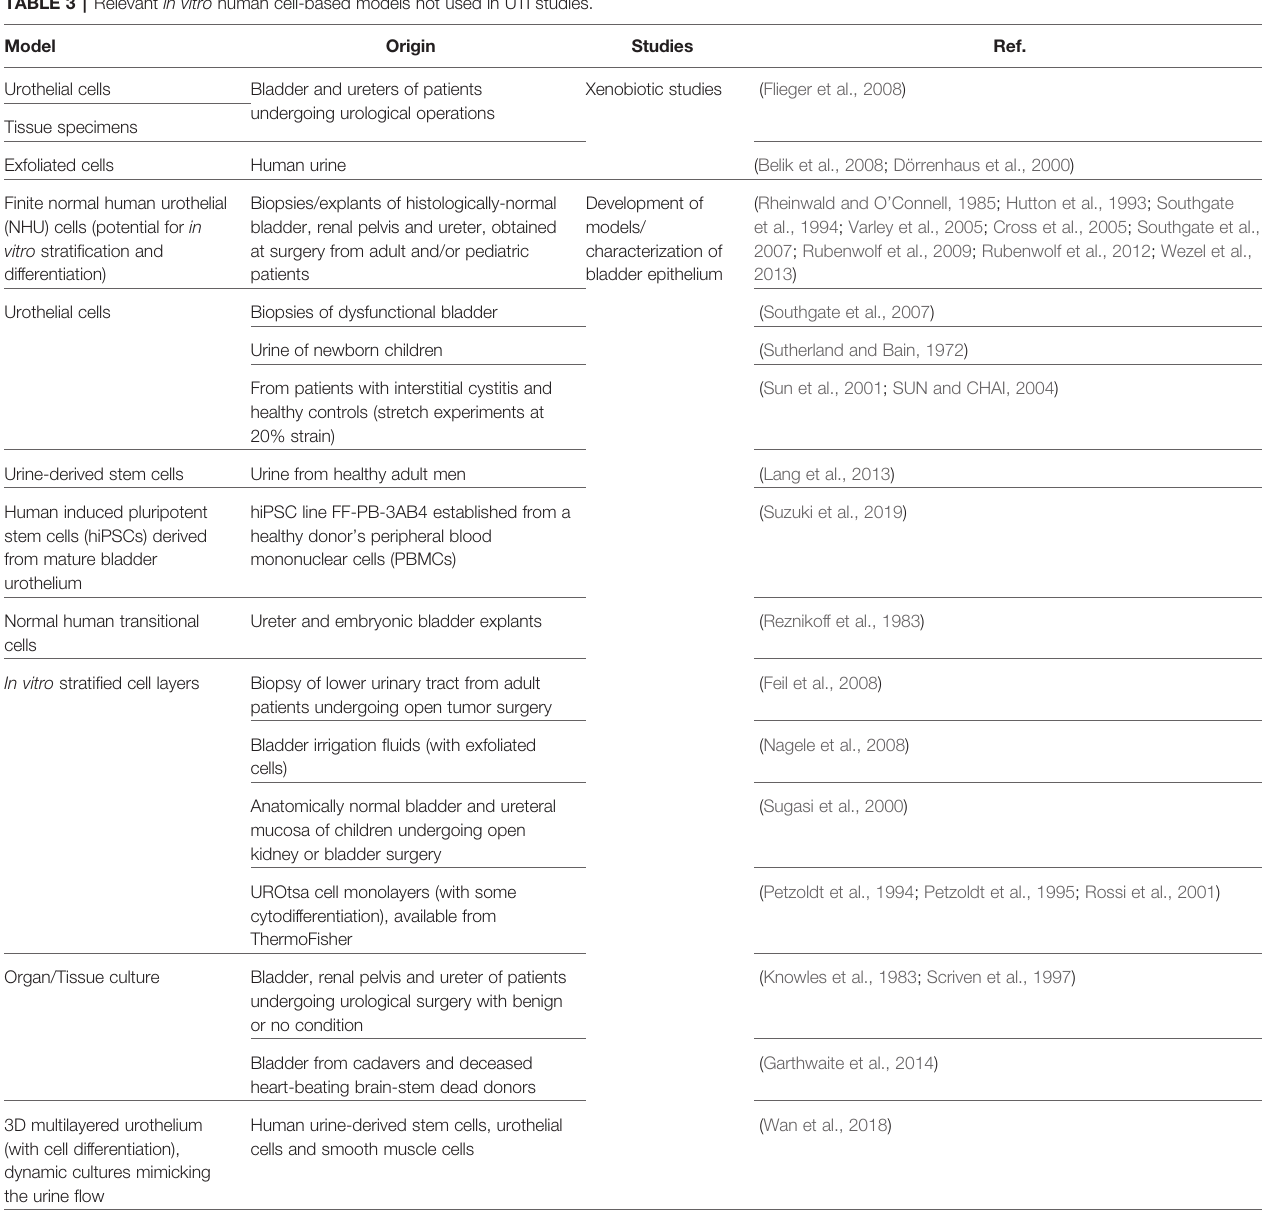
TABLE 3 | Relevant in vitro human cell-based models not used in UTI